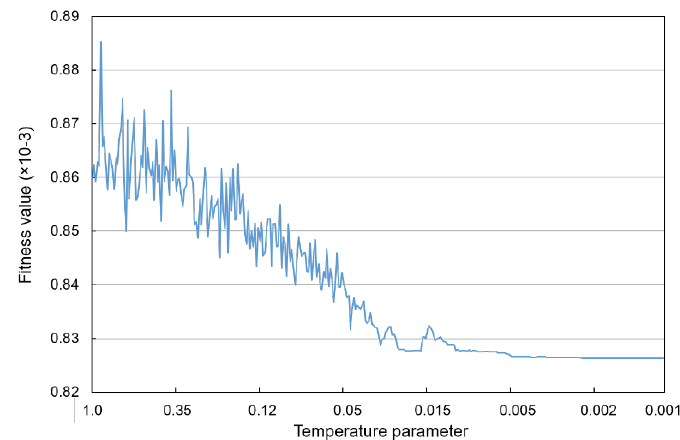
Figure 10. Fitness variation during the process in case study (c). Table 5. Layout Results for Case Study (c).